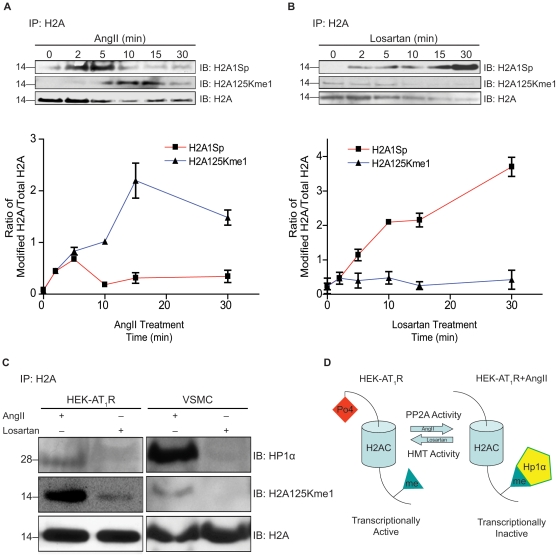
Time course analysis of ligand-dependent change of H2A-PTMs.Dephosphorylation of H2A detected by H2A1Sp antibody and monomethylation of H2A detected by the H2A125Kme1 antibody. (A) Time course of H2A1Sp and H2A125Kme1 signal modulation in HEK-AT1R treated with AngII (1µM); (B) HEK-AT1R cells treated with losartan (1µM). (C) H2A125Kme1 interaction with HP1α in HEK-AT1R and HASMC treated with AngII (1µM) or losartan (1µM) for 1 hr. Nuclear extracts of various samples were immunoprecipitated using pan-H2A antibody followed by immunoblotting for H2A125Kme1 and HP1α in the immunoprecipitate, (D) Schematic representation of functional consequences of two H2A-PTMs affected by activation states of the AT1R.